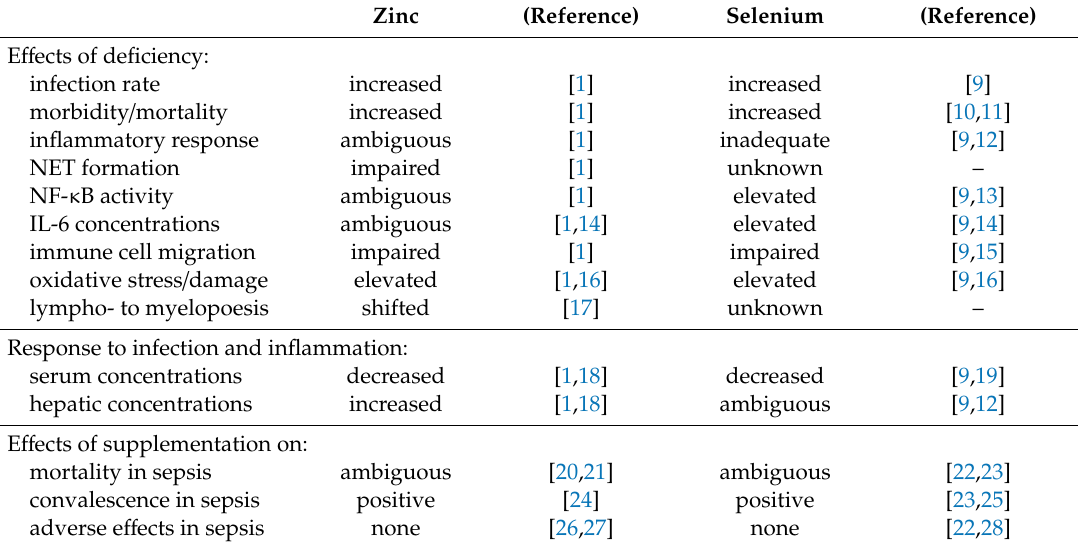
Table 1. Parallels and di ff erences in the interaction of Zn and Se with infection and inflammation. Zinc (Reference) Selenium